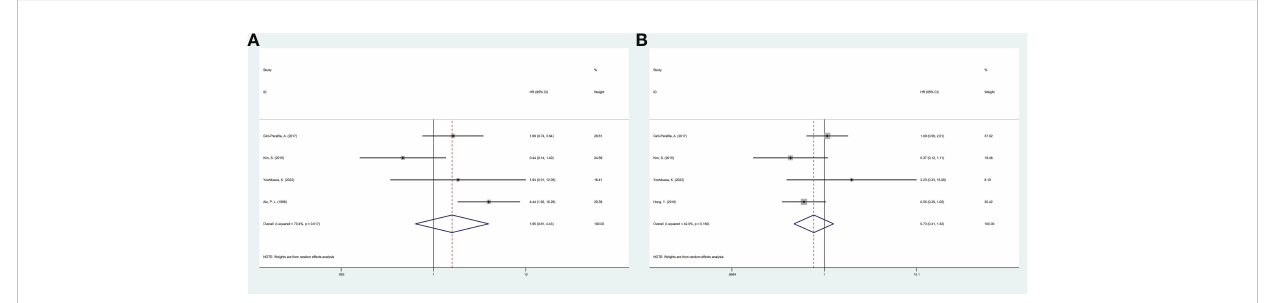
FIGURE 2 Meta-analysis of fatty acid synthase expression level and prognosis of breast cancer patients. (A) Forest plot of associations between fatty acid synthase expression level and DFS/RFS of patients. (B) Forest plot of associations between fatty acid synthase expression level and OS. DFS, disease- free survival; RFS, relapse-free survival; OS, overall survival.